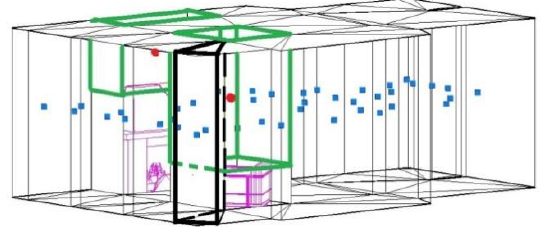
Figure 11. Triangular prism and feature